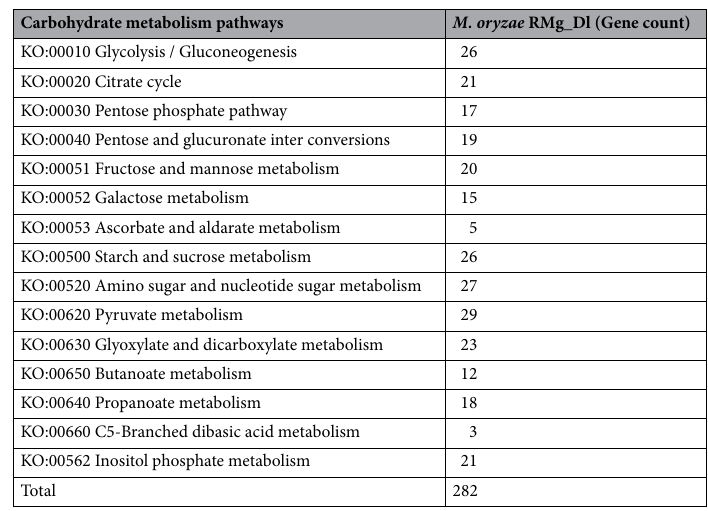
Table 4. Carbohydrate metabolism KEGG (Kyoto Encyclopedia of Genes and Genomes) pathway for M. oryzae RMg_Dl.